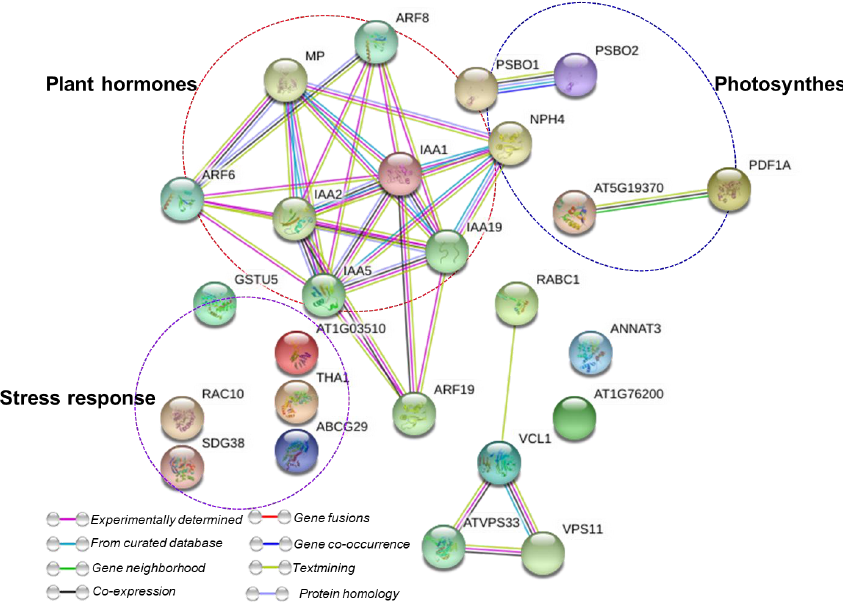
Figure 6. Analysis of protein interaction network by STRING 9.1. TAIR (the Arabidopsis information resource) homologous proteins from identified proteins were mapped by searching the STRING 9.1 software with a confidence of 0.4 using Arabidopsis thaliana . Colored lines between the proteins indicate the various types of interaction evidence. The clusters of highly interacting protein nodes are marked with oval dotted lines and include proteins involved in stress response, photosynthesis, and plant hormones.